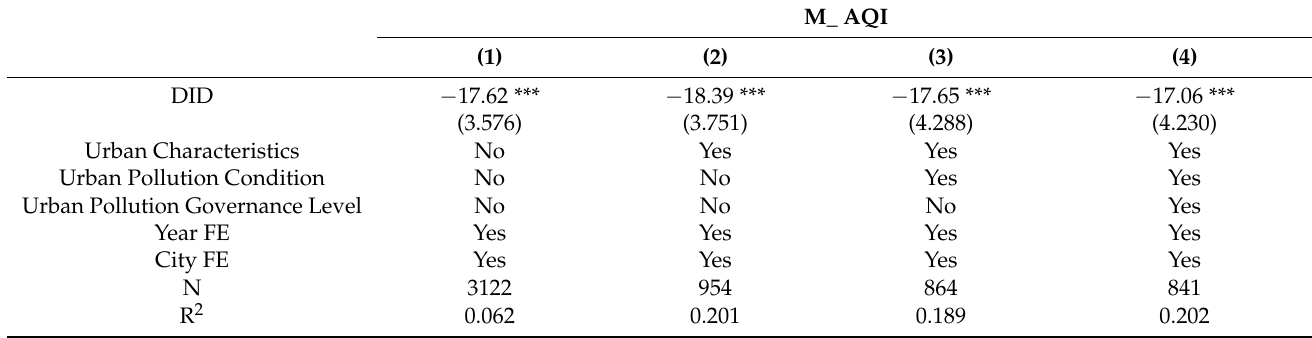
Table 2. The Impact of Policy on AQI for Baseline